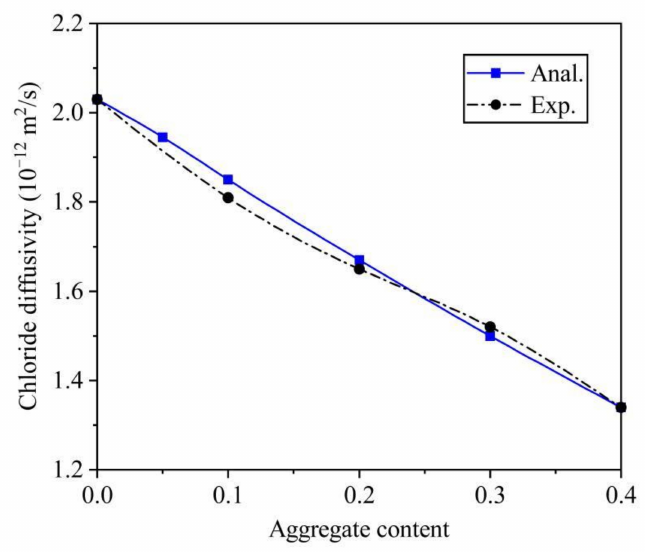
Figure 6. Comparison with test data from Yang and Su. With consideration of the impact of aggregate shape (e.g., µ ) on D c , a sensitivity analysis was performed. It should be pointed out that, all the parameters, but aspect ratio, were the same as the second set of validation. For D i = 9.5 × 10 − 12 m 2 /s, h = 0.04 mm, µ = 1, 2, and 3, the variations of D µ can be seen in Figure 7. For C c with C a and a = 0.1, 0.2, 0.3, and 0.4, when µ decreased from 3 to 1, D c was increased by 3.4%, 6.1%, 8.0%, and 12.8%, respectively. For µ = 1, 2, and 3, when C a was up from 0.1 to 0.4, D c has a reduction of 31.9%, 38.1%, and 43.9%, respectively.